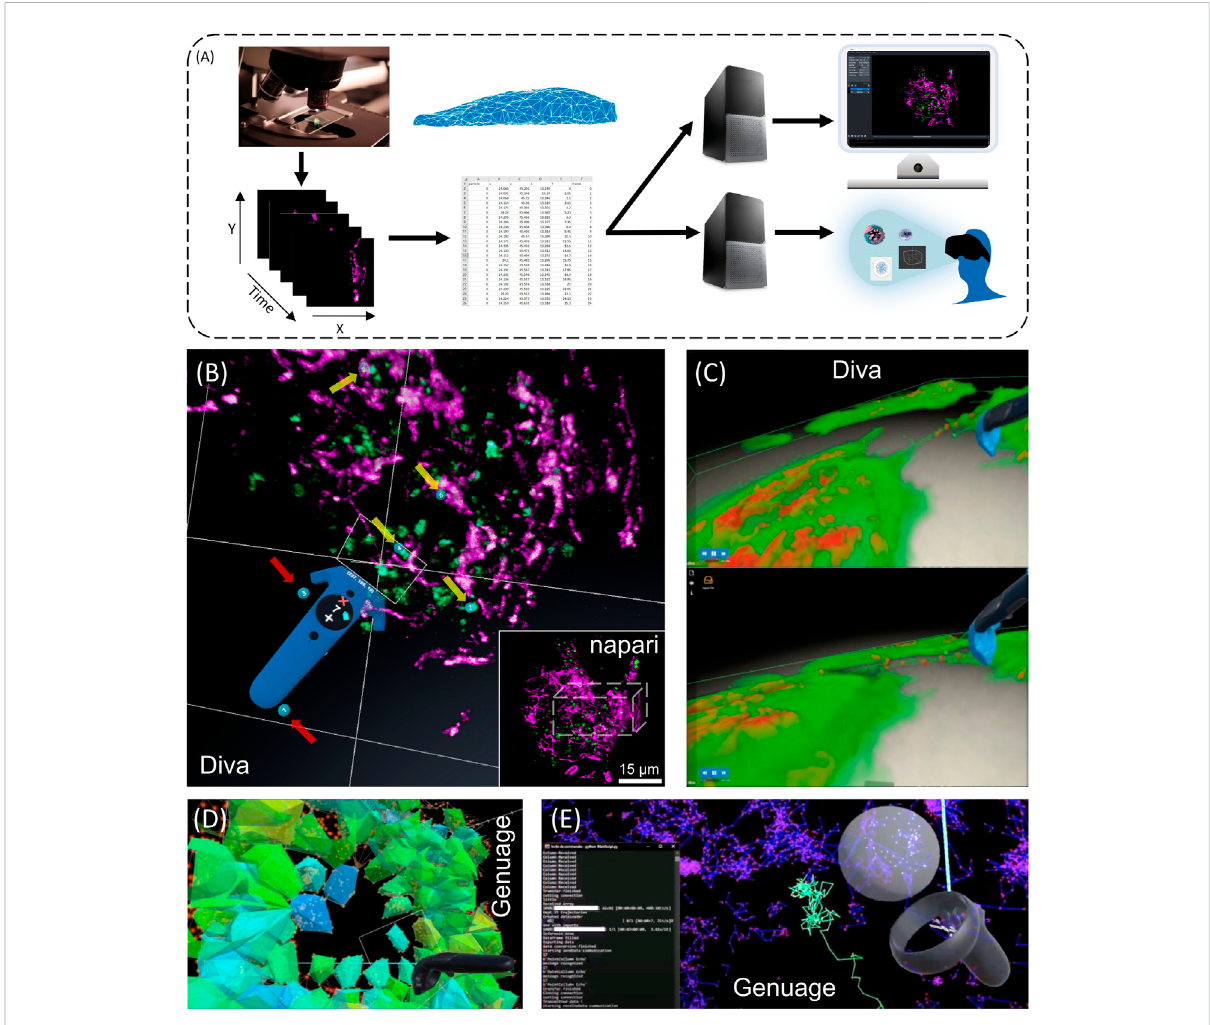
FIGURE 1 Exploring 3D + time intracellular microscopy data. (A) 3D + t visualization modes. Flat screen and VR/AR share identical processes. From left to right, image acquisition and preprocessing (denoising, registration, reconstruction, and deconvolution); post processing (segmentation, mesh, and trackinganalysis)anddataannotationconstitutesimilarinput.Forkintheroadstartsatadownstreamcomputinglevelfor3Drendering,whichdiffers between fl atscreen and VR/AR visualizations, with additional interactive tools for the latter (e.g., Microsoft Hololens, Headsets, Oculus, eye trackers, haptic gloves) (B) VR visualization an interaction using Diva of a live RPE1 cell expressing CD63-Turquoise.2 labeling late-multivesicular endosomesandstainedwithPKMOrange(Liuetal.,2022),labelingmitochondriaacquiredwithLLSM.Divingintothestackallowspreciseselectionin 3D and it allows to adapt the angle of vision of green structures of interest (endosomes) (yellow arrows, numbered blue tags), accordingly to their distance to the magenta structures (mitochondria). Continuous visual penetration in the 3D space allows to precisely select more of them (yellow arrows, numbered blue tags) while previously selected ones remain tagged (red arrows, numbered blue tags). Coordinates and information of the selected structured are recorded for further analysis and tracking in time. In the inset thumbnail image, a corresponding full 3D stack of 54 planes of thesame cell isshown using thenapariviewer,where theparallelepipedwhite box depictsthe volume manipulated in Diva. The sameoriginal 3D+ t data set is also used in Figures 2D,E and in Supplementary Video S3. (C) Dynamic exchange of mitochondria between cells using Tunneling Nanotubes(TNT)(Courtesy ofChiaraZurzolo ’ slab,InstitutPasteur)visualizedwithDIVAinVR(seeSupplementaryVideoS1).Renderingisperformed by full volumetric ray casting (el Beheiry et al., 2020) and an adapted transfer function (Guérinot et al., 2022). Note the possibility to have both the video running and the user interacting with thedata. Exploring 3Dsingle particle trajectories in time using Genuage (D,E) . Data are initially presented as point clouds and segment in Genuage, while physical properties maps (D) , such as coef fi cient diffusion are overlaid to the point cloud